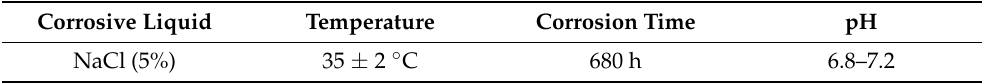
Figure 2. The 3D morphology of MAO coatings. ( a ) S0; ( b ) S1; ( c ) S2; ( d ) S3; ( e ) S4.